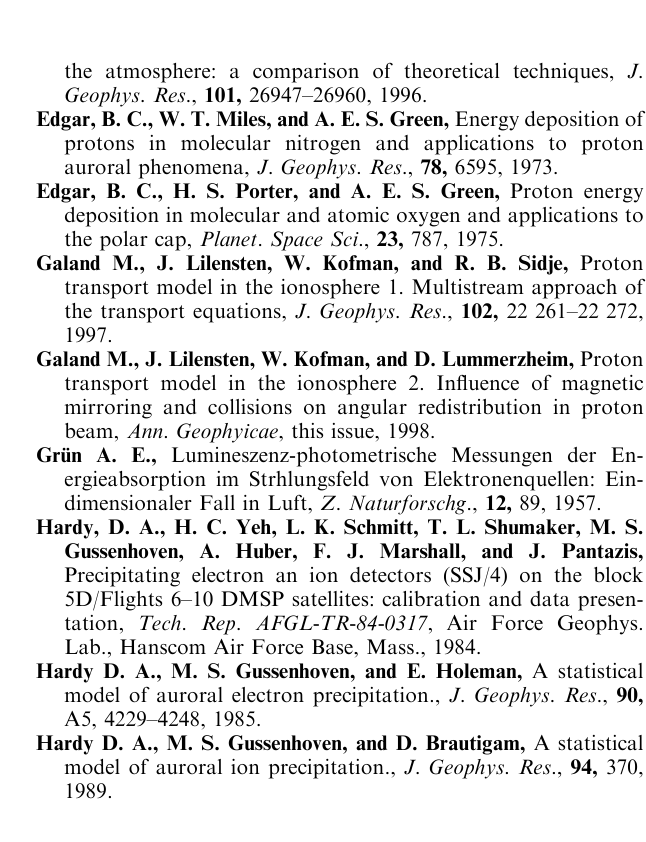
Fig. 10. Same as Fig. 9 for the electron density in electron (cid:225) cm )